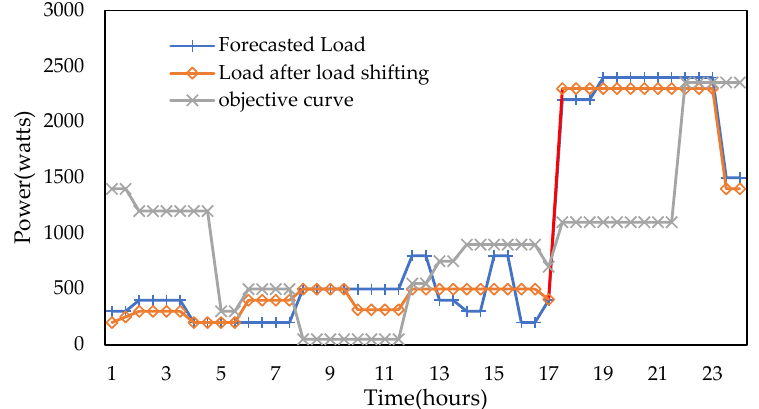
Figure 11. DSM results of residential load under summer conditions.